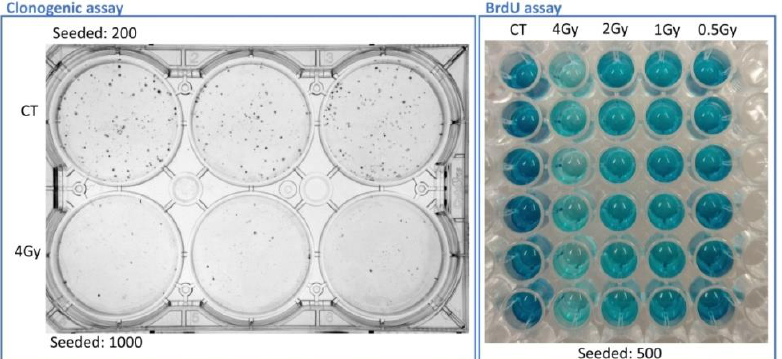
Figure 4. A375 plates for both clonogenic and proliferative assays. Left, plate for clonogenic assay with the control sample (CT) and the sample irradiated with a neutron dose of 4 Gy at day seven after irradiation. Right, BrdU cell proliferation assay of control and irradiated cells at day four after irradiation. The samples were analyzed in triplicate for each data point.